Question: Provide a one-line summary of what is displayed.
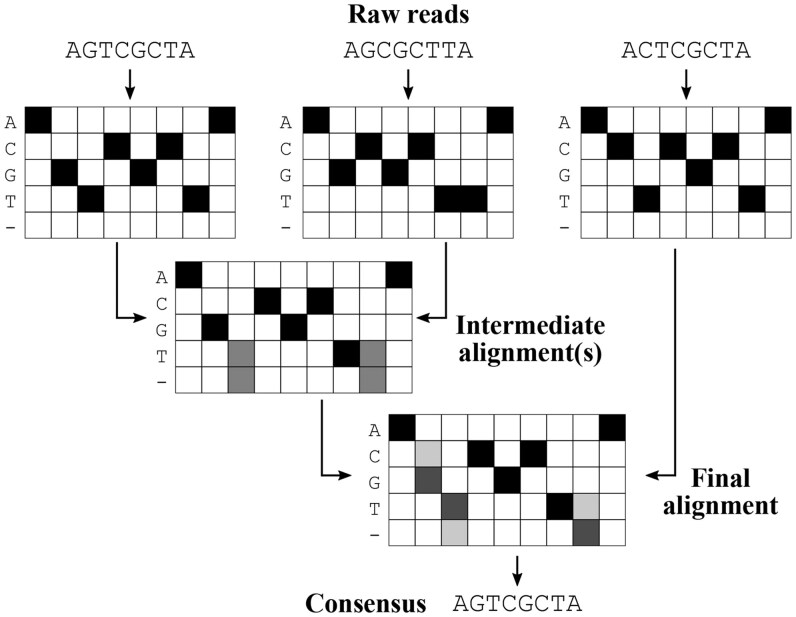
Answer: Flowchart with a toy model showing the progressive alignment strategy of BCAR. Reads are represented as arrays with entries corresponding to quality scores, then progressively aligned using a modified implementation of the Needleman-Wunsch algorithm ( Needleman and Wunsch 1970 ). At each step, the new read is aligned against the current consensus, using a scaled cosine similarity to determine match scores between ambiguous positions. Gaps are removed from the final alignment during consensus generation.